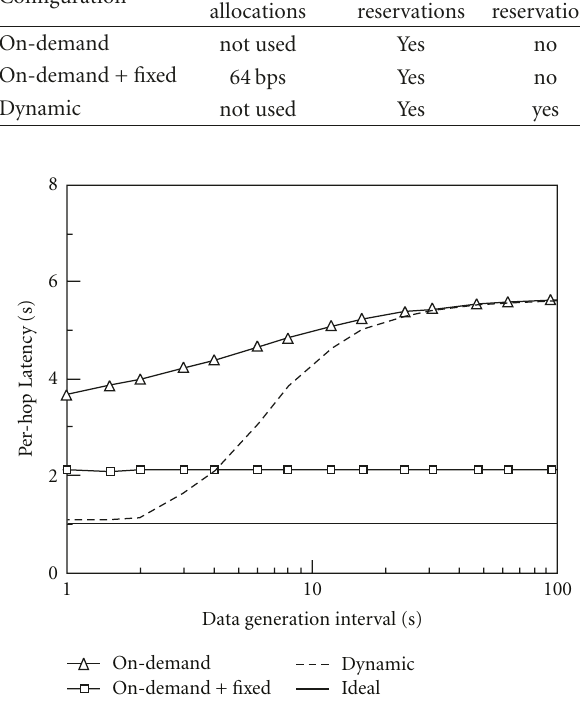
Figure 17: One-hop latency with di ff erent contention-free slot allocation methods.